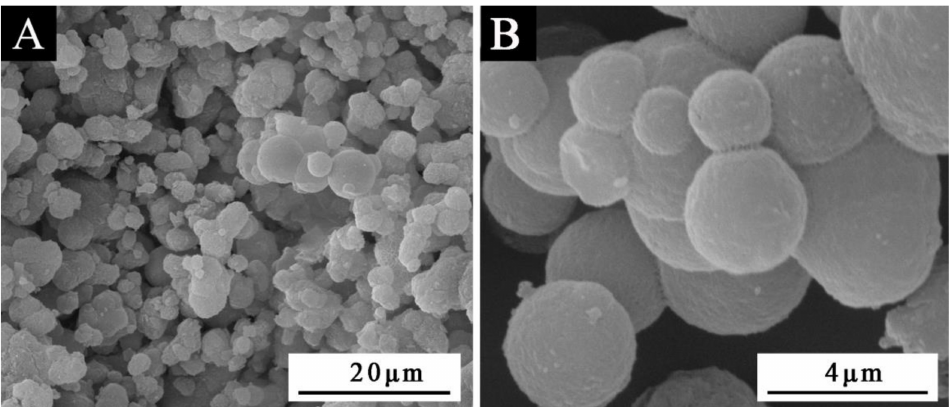
Figure 2. SEM of Nippon water-based emulsion microcapsules.